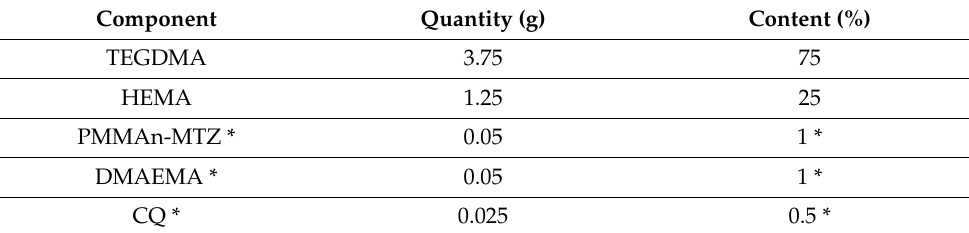
Table 2. Composition and percentage content of the experimental